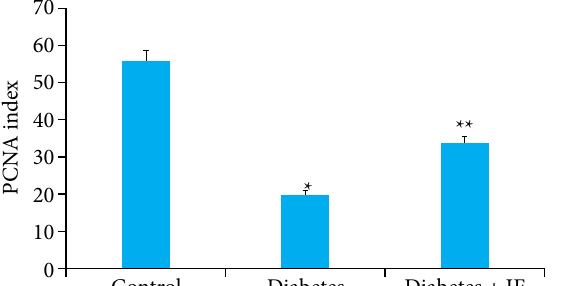
Figure 6 – Apoptotic index values of control, diabetes, and diabetes+IE groups. *p < 0.001 compared to diabetes group. **p < 0.01 compared to diabetes+IE